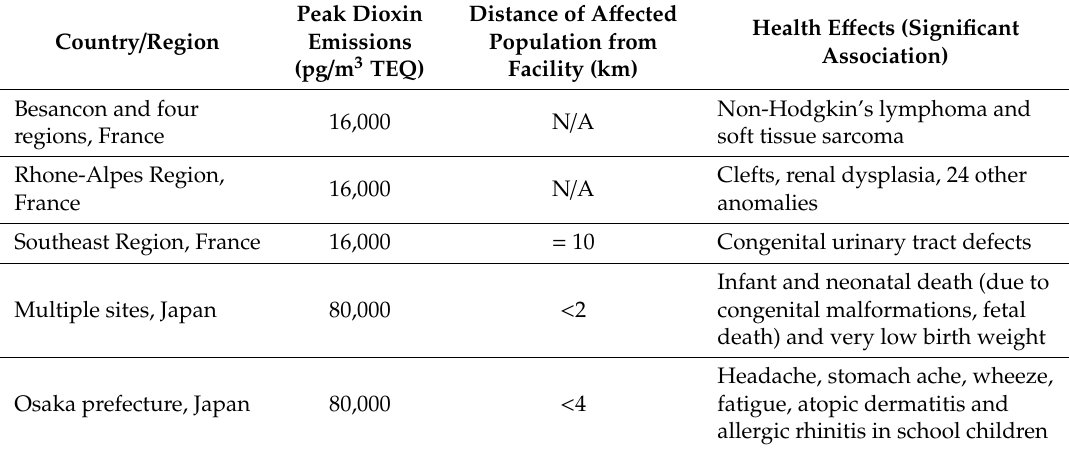
Table 8. The relation of peak dioxin levels from various incineration plants studies associated with health e ff ects